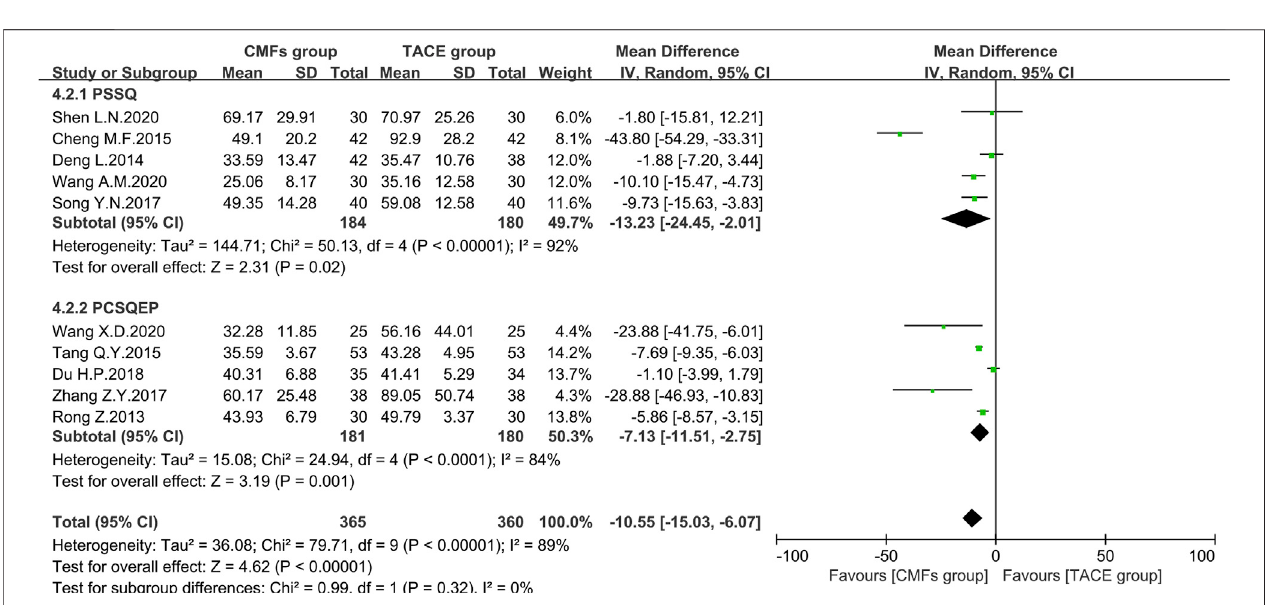
FIGURE 10 | Effect of CMFs group versus TACE group on AST, including a comparison between PSSQ and PCSQEP in the subgroup.